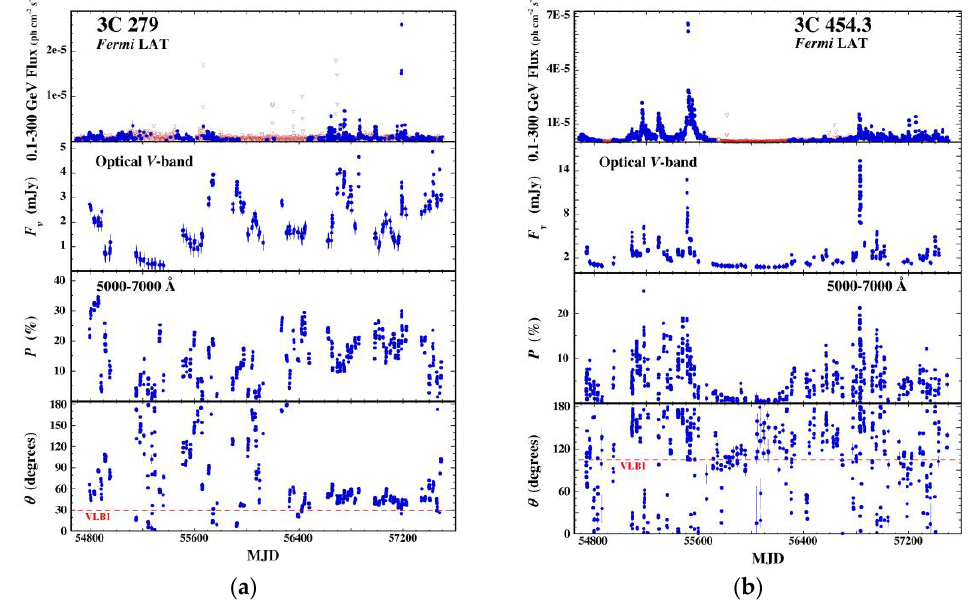
Figure 2. The γ -ray and optical behavior of ( a ) 3C 279 and ( b ) 3C 454.3 since the launch of Fermi. The Fermi γ -ray light curve is comprised of daily measurements made by the LAT, with red symbols in the top panels indicating daily γ -ray flux upper limits. Error bars are included for all optical measurements, but are typically smaller than the plotted data points. Uncertainties in the V flux density measurements of 3C 279 are dominated by the uncertainty in the flux calibration of the comparison star used for differential spectrophotometry. The magnitude differences between 3C 279 and the comparison star are known to higher precision. Following the standard way chosen to report spectropolarimetric measurements in the public data archive, P and θ are determined using the median Stokes parameters in a 5000–7000 Å bandpass. In the bottom panels of both plots, a red dashed line denotes the approximate position angle of the inner VLBI jet at 43 GHz.